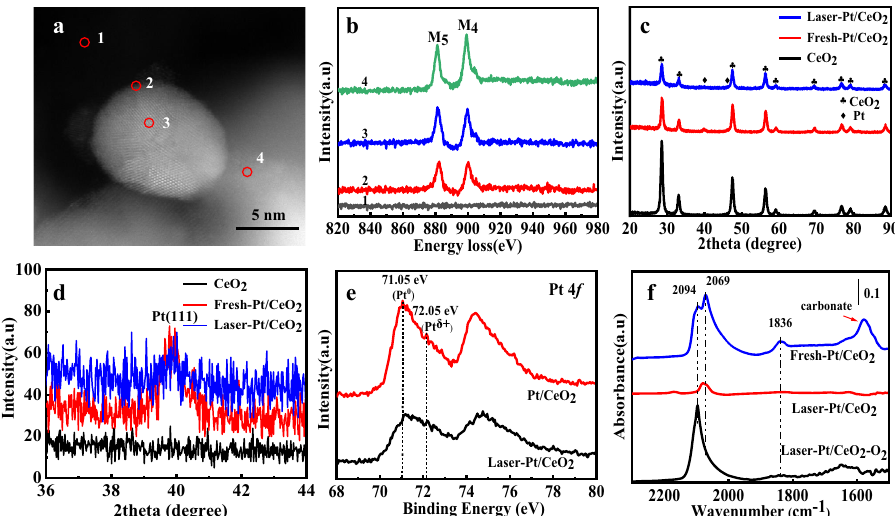
Fig. 3 Structural characterizations. a High-angle annular dark- fi eld scanning transmission electron microscopy (HAADF-STEM) image of laser-irradiated Pt/CeO 2 . b EELS spectrum of laser-irradiated Pt/CeO 2 . c , d XRD spectra of Pt/CeO 2 and laser-irradiated Pt/CeO 2 . e XPS spectra of fresh Pt/CeO 2 and laser-irradiated Pt/CeO 2 . f In situ CO-DRIFT of fresh Pt/CeO 2 and laser-irradiated Pt/CeO 2 CeO x species. Figure 3c, d illustrates the XRD spectra of the